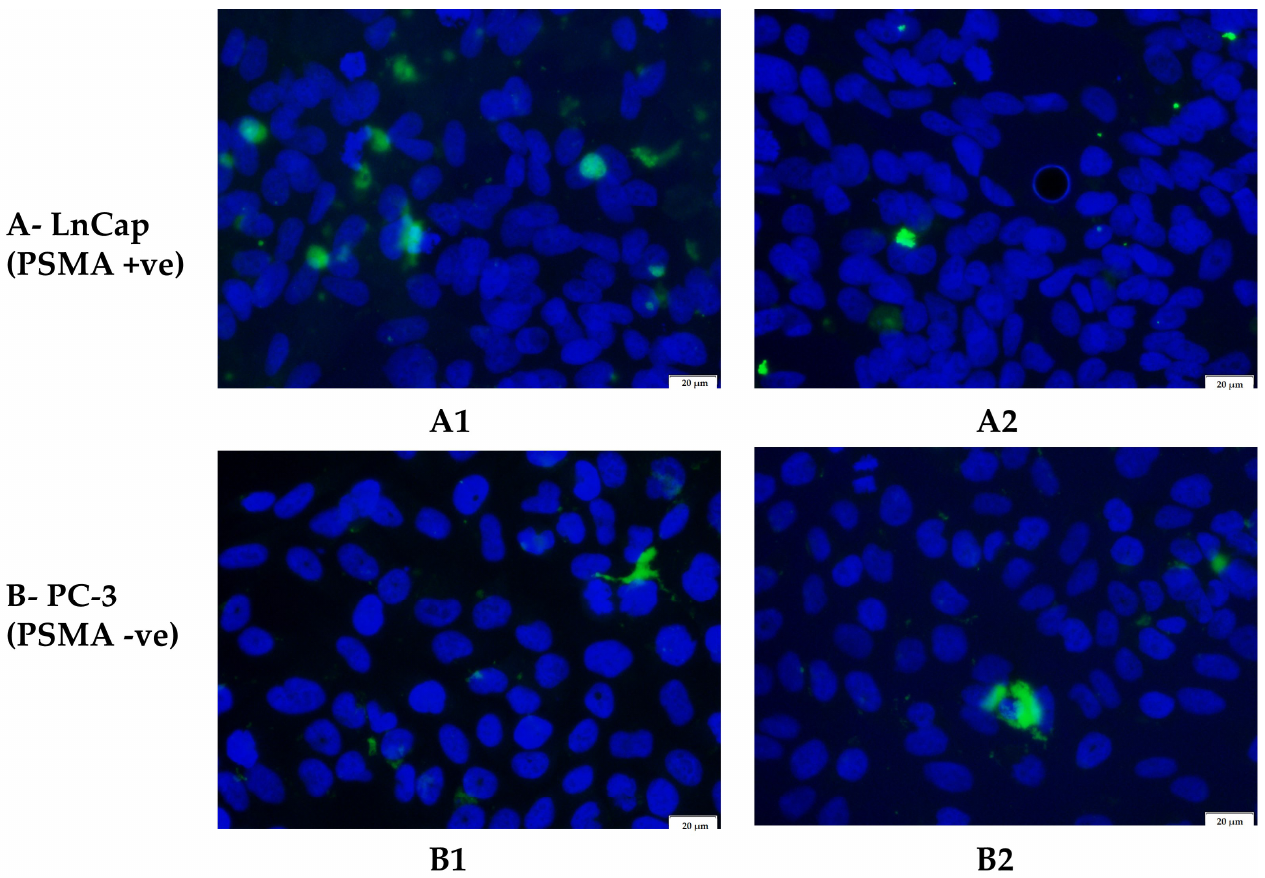
Figure 9. ( A ) LnCap cells and ( B ) PC-3 cells treated with coated ( 1 ) and uncoated ( 2 )